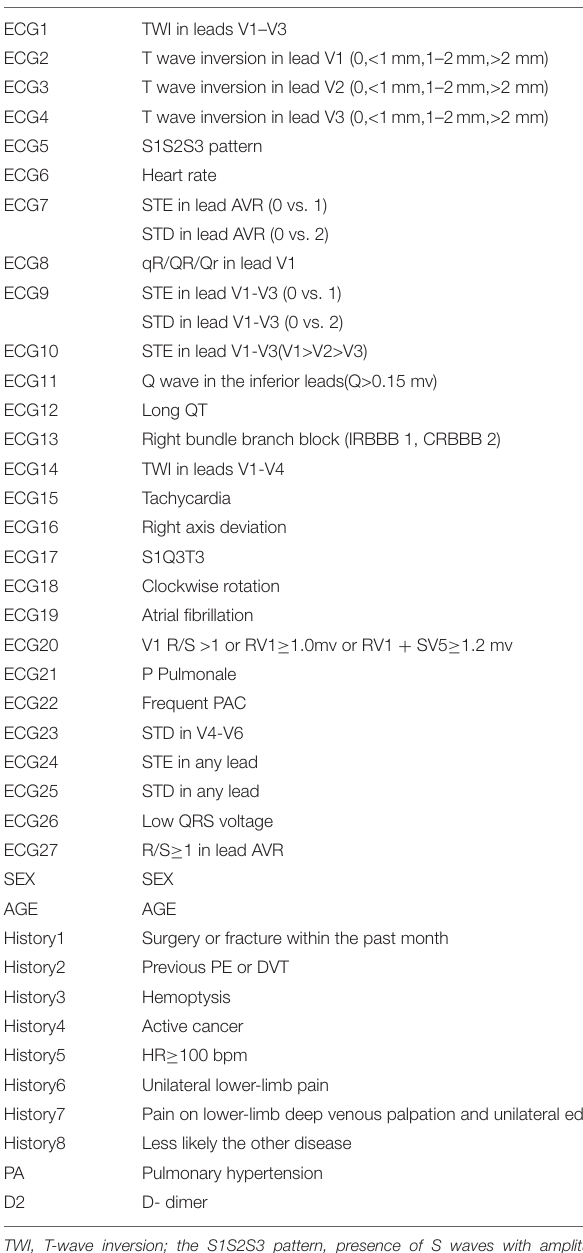
TABLE 1 | The 27 ECG and 12 clinical characteristics analyzed in our